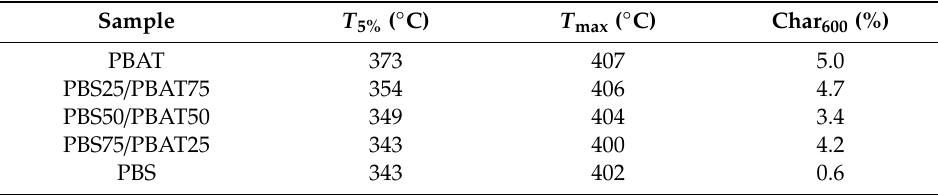
Figure 8. ( a ) Thermogravimetric (TGA) curves and ( b ) derivative (DTG) TGA curves of PBAT, PBS their blends under nitrogen. and their blends under nitrogen. Table 3. Thermal parameters of PBAT, PBS and their blends from TGA. Table 3. Thermal parameters of PBAT, PBS and their blends from TGA.